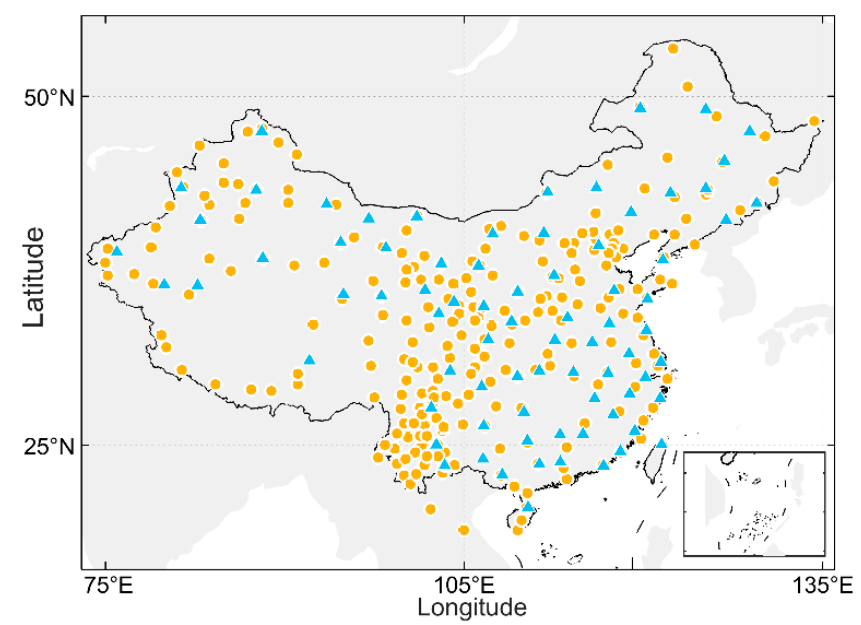
Figure 1. Geographical distribution of 78 radiosonde stations (blue triangle) and 246 ground-based GNSS stations in the CMONOC (orange circle).